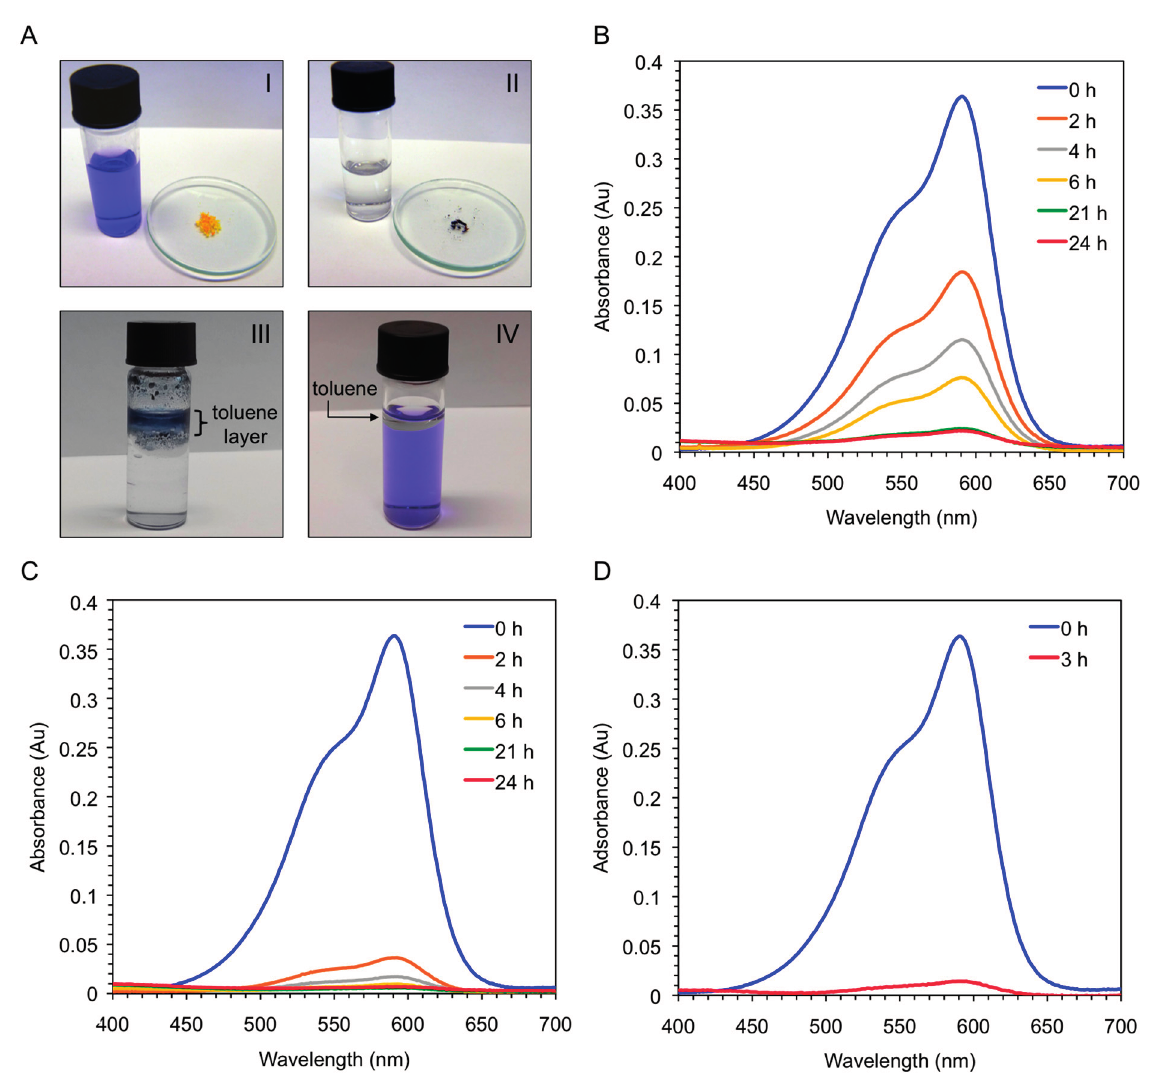
Figure 9. ( A-I ) Aqueous solution of crystal violet ( c = 1 × 10 − 5 mol·L − 1 ) before addition of either bis-A4 (1.0% w / v ; yellow powder in watch glass) or the corresponding xerogel obtained by freeze-drying the gel prepared from bis-A4 in toluene (1.0% w / v ); ( A-II ) Previous solution after dye removal by the xerogel (dark-blue powder in watch glass); ( A-III ) Mixture obtained after addition of toluene and bis-A4 (1.0% w / v ) to an aqueous solution of crystal violet ( c = 1 × 10 − 5 mol·L − 1 ). Ratio water:toluene 1:0.1 v / v . The picture was taken 3 h after shaking the mixture at room temperature; ( A-IV ) Mixture containing an aqueous solution of crystal violet ( c = 1 × 10 − 5 mol·L − 1 ) and toluene. Ratio water:toluene 1:0.1 v / v . The picture was taken after shaking the mixture at room temperature; ( B ) UV-vis absorption spectra of the aqueous solution of crystal violet showing the time-dependent adsorption of the dye by freshly synthesized peptide bis-A4 ; ( C ) UV-vis absorption spectra of the aqueous solution of crystal violet showing the time-dependent adsorption of the dye by the corresponding xerogel; and ( D ) UV-vis absorption spectra of the aqueous solution of crystal violet showing the time-dependent removal of the dye after addition of toluene (ratio water:toluene 1:0.1 v / v ) and peptide bis-A4 at room